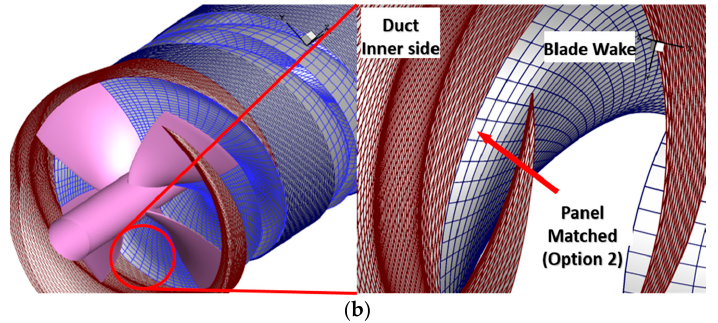
Figure 3. Unmatched ( a ) and matched ( b ) panels between the duct inner side and the outer edge of the blade wake using Option 1 and 2, respectively. Cylindrical duct wake is assumed with the penetration control on the blade wake. Only half the duct is shown for clarity.